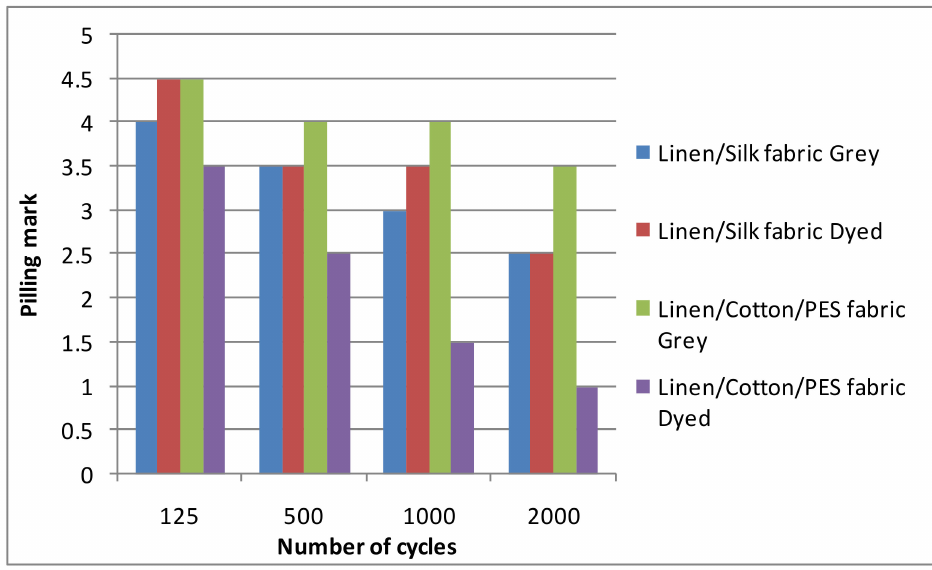
Figure 4. Pilling marks of grey and dyed linen/silk fabrics without additional mechanical